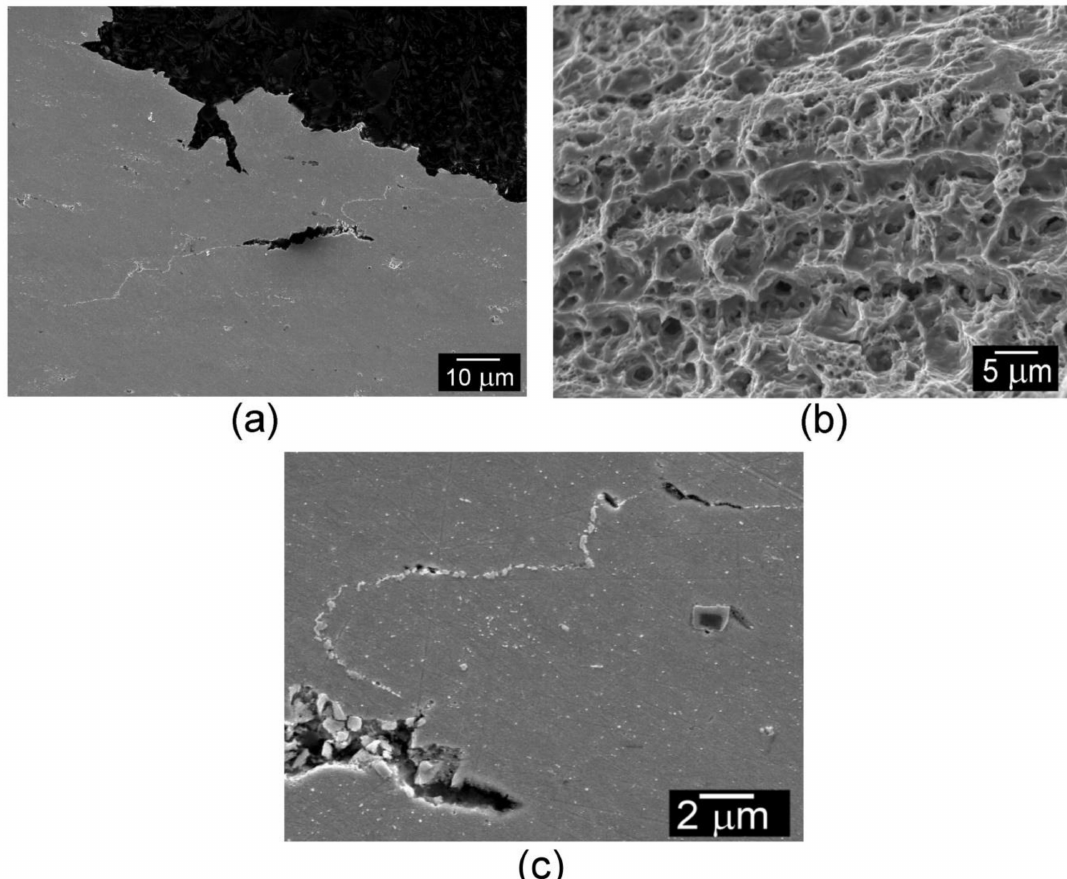
Figure 13. Fracture analysis of the failure in Ni WM central region after room-temperature tensile test of T92/TP316H dissimilar weldment in “QT PWHT + 620 ◦ C/500 h” condition: Fracture path and microstructure beneath the failure ( a ); Fracture surface showing dimple areas ( b ); Detailed view of the mechanisms of plasticity deterioration ( c